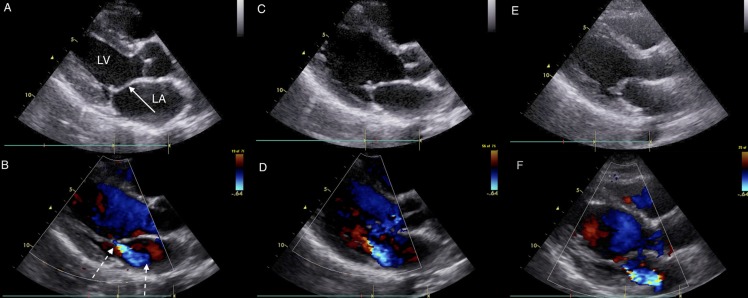
Images from a family with 3 RHD positive members: Index Case, Sibling and Mother.Parasternal long axis echocardiographic still frames in early systole in black and white (panels A, C, and E) and color Doppler (panels B, D, and F) of RHD positive index case (panels A and B), sibling (panels C and D) and mother panels (E and F). The black and white panels all show a thickened anterior mitral valve leaflet (solid arrow) and prolapse (excessive tip motion) of tip of anterior mitral valve leaflet. The mother has the most extreme thickening of the valve along with thickened chordae and immobile valve motion (not seen on these frames). The color Doppler panels show similar mitral regurgitation jets (dotted arrows) measuring approximately 3 cm in each subject. Both RHD positive index case and sibling also had aortic insufficiency jet measuring > 1 cm (not shown). Abbreviations: LA–left atrium, LV–left ventricle.